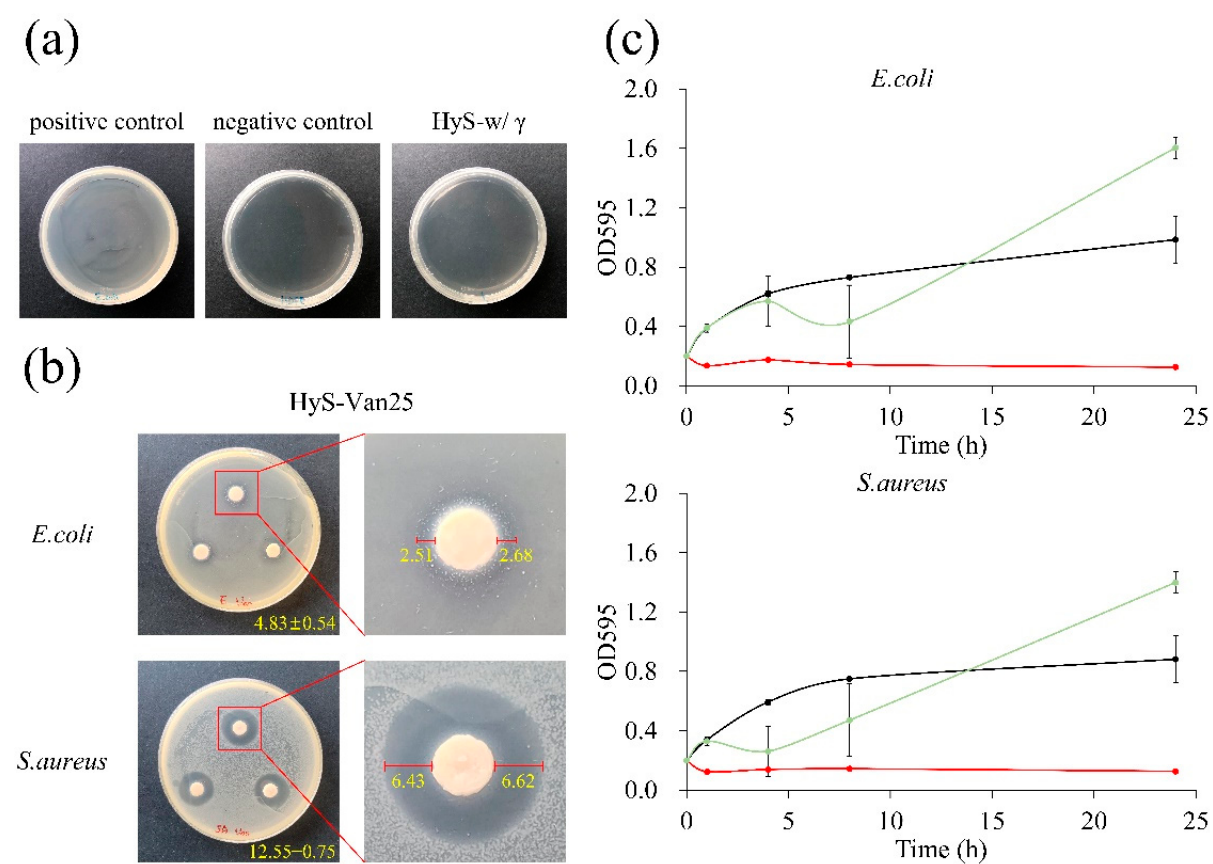
Figure 7. ( a ) Qualitative analysis of the sterility assurance of hydrogel macrospheres after sterilization (HyS-w/ γ ). ( b ) Qualitative results of the disk diffusion antibacterial effect of hydrogel macrospheres impregnated with vancomycin (HyS-Van25, n = 3) against E. coli and S. aureus after 24 h of interaction. Right figures indicate the inhibitory zones formed by the presence of macrospheres with a diameter of 6 mm. ( c ) Quantitative antibacterial results of hydrogel macrospheres impregnated with vancomycin after irradiation (HyS-Van25, n = 3) against E. coli and S. aureus after 24 h of interaction under broth